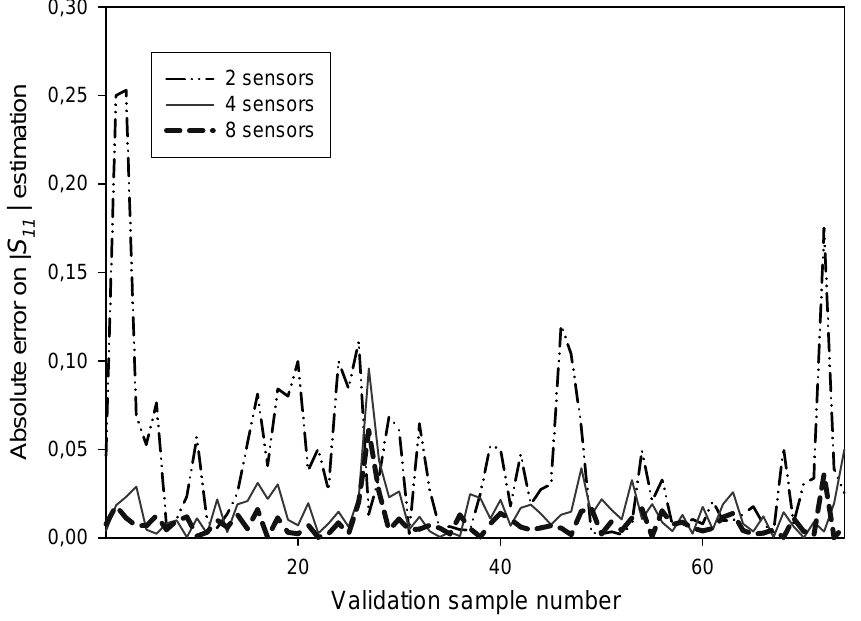
Figure 16. Behaviour of the reflectometer when different numbers of detectors are